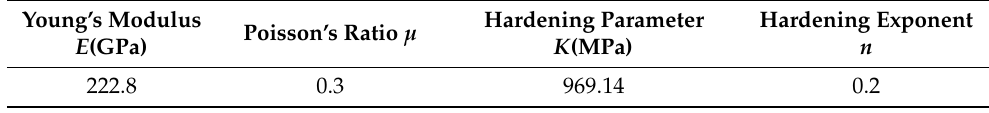
Table 2. Mechanical properties of the Q460 high-strength steel